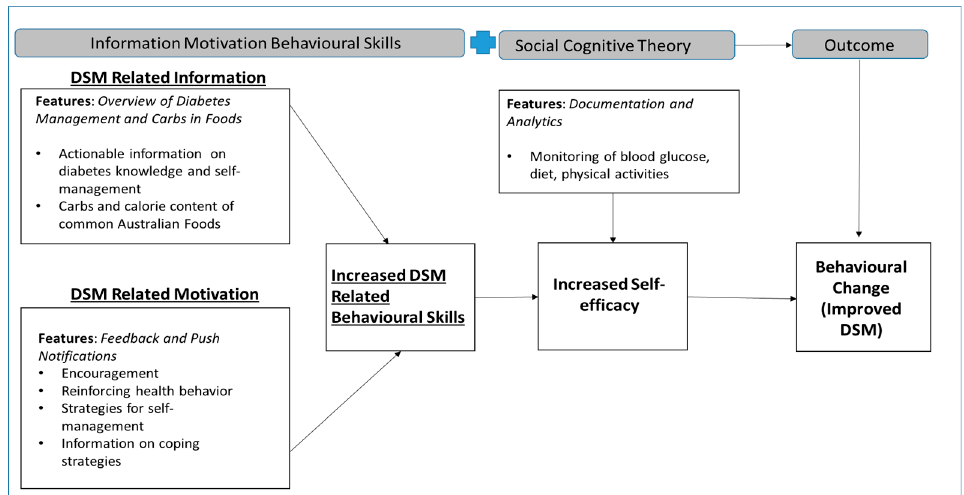
Figure 1. Conceptual framework for My Care Hub based on blended Social Cognitive and Information Motivation Behavioural Skills (IMBS) models.